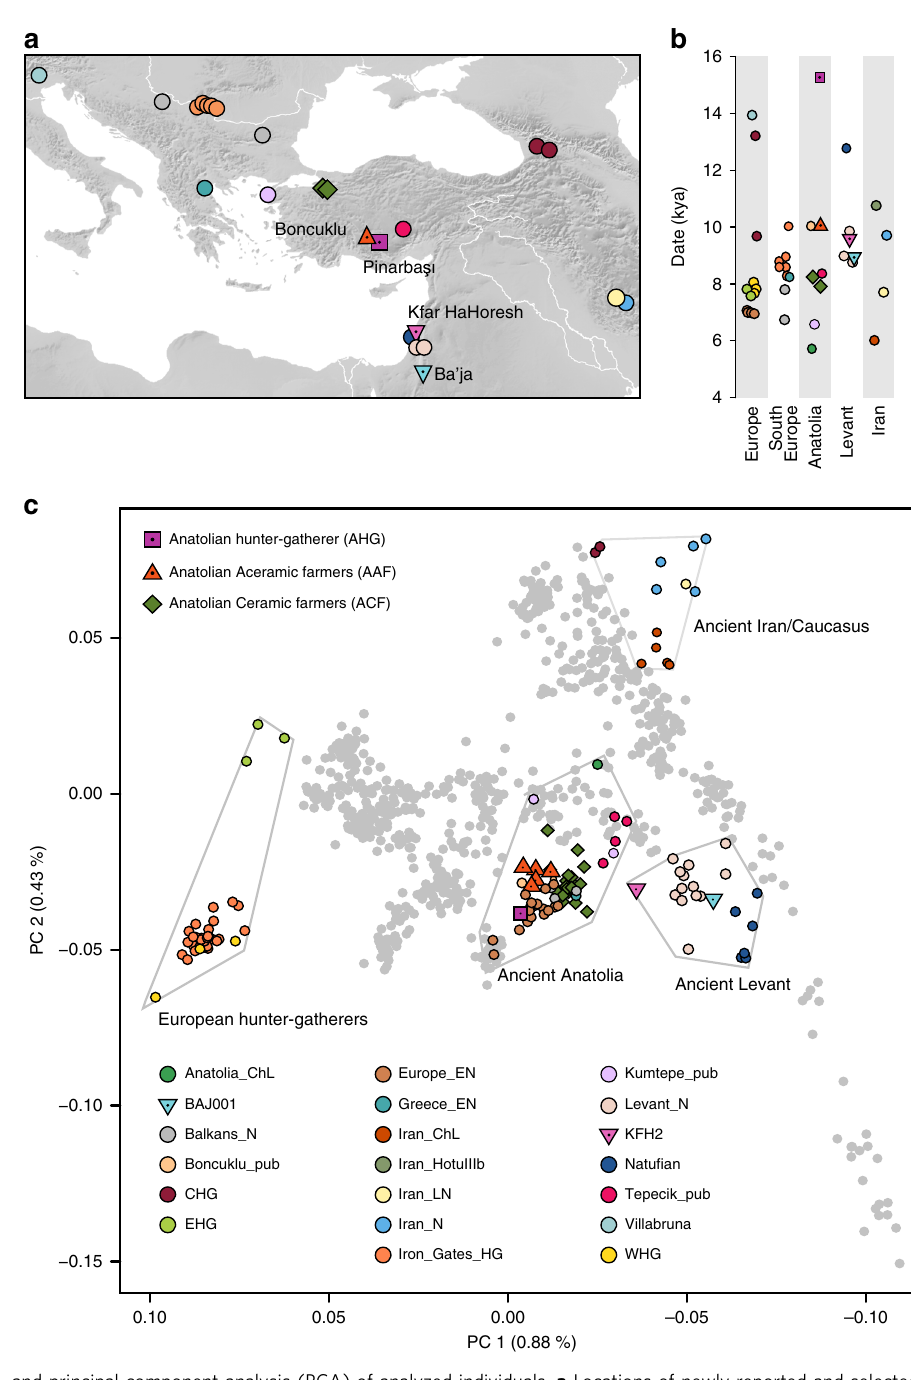
Fig. 1 Location, age, and principal component analysis (PCA) of analyzed individuals. a Locations of newly reported and selected published genomes. Archeological sites from which new data are reported are annotated. Symbols for the analyzed groups are annotated in c . b Average ages of ancient groups. c Ancient genomes (marked with color- fi lled symbols) projected onto the principal components computed from present-day west Eurasians (gray circles) (Supplementary Figure 8). The geographic location of each ancient group is marked in a . Ancient individuals newly reported in this study are additionally marked with a black dot inside the symbol. Source data are provided as a Source Data fi